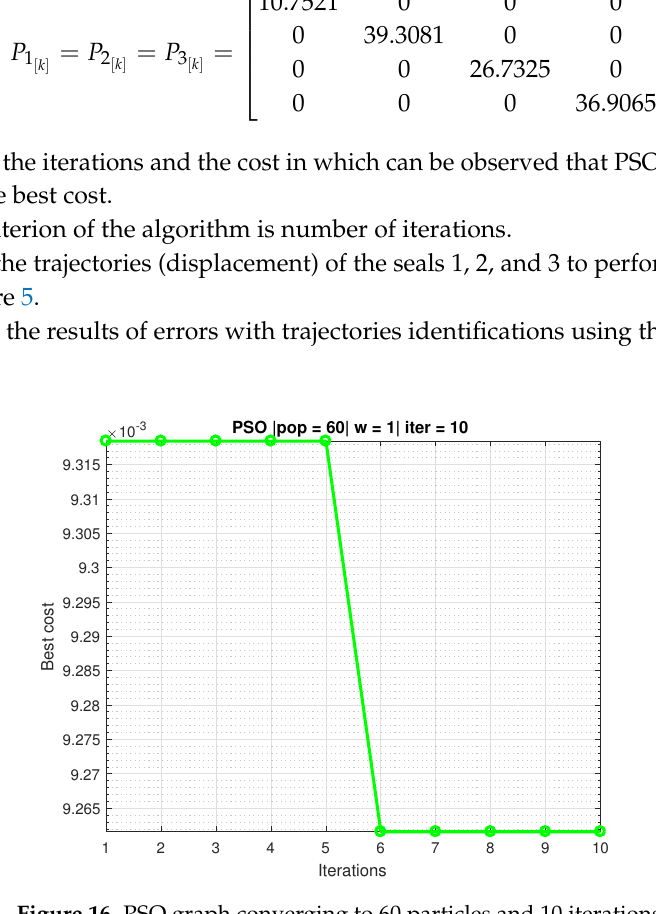
Figure 16. PSO graph converging to 60 particles and 10